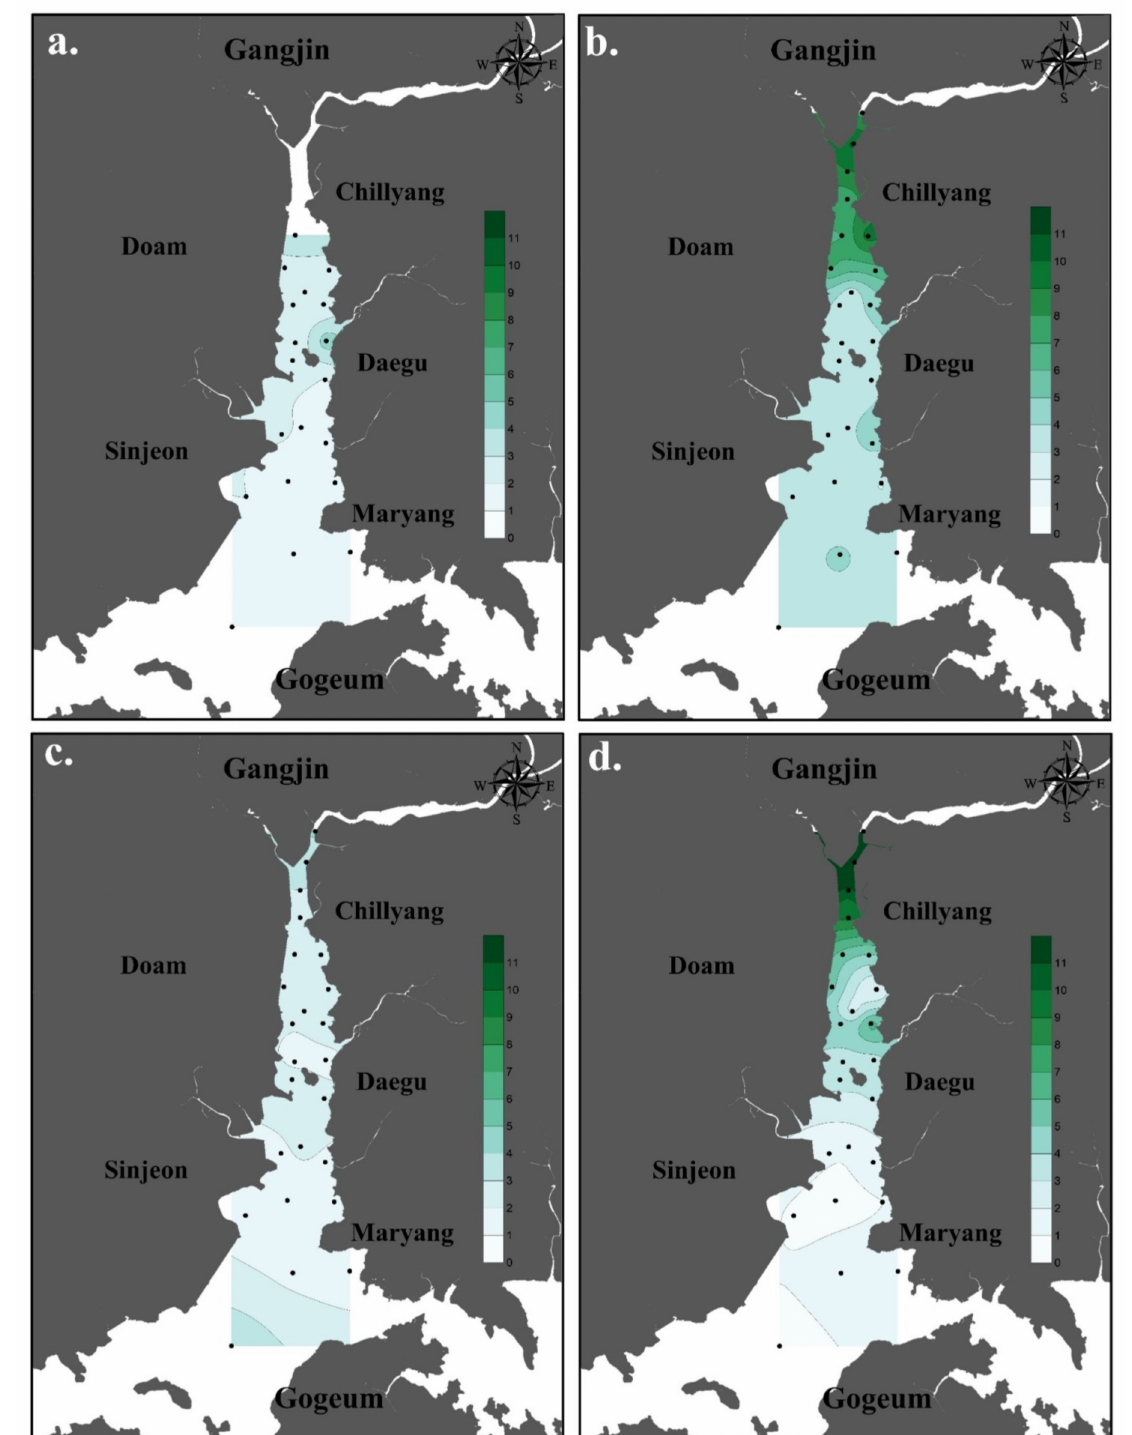
Figure 4. Horizontal distribution of surface chlorophyll- a concentrations (ug/L) during the study period: ( a ) spring, ( b ) summer, ( c ) fall, ( d )